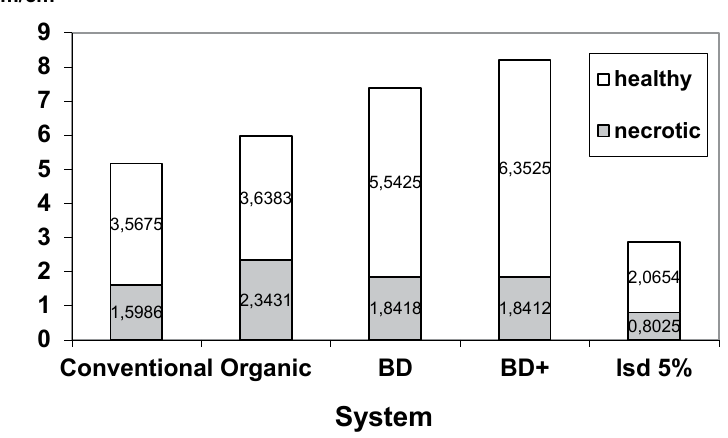
Figure 8: Effects of farming system on root length in 1999